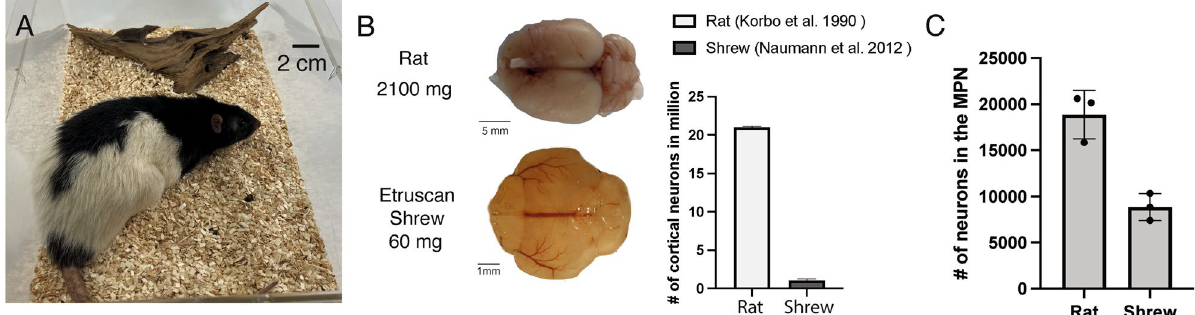
Figure 4. Neocortical and MPN neurons count in rats and Etruscan shrews. ( A ) Comparison of the body size between adult male Etruscan shrew and male rat (6-month-old). ( B ) Left, rat and Etruscan shrew brains. Right, the rat brain contains about 20 × more cortical neurons than that of the shrew. Exact numbers extracted from (Naumann et al. 2012; Korbo et al. 1990) 11,12 and illustrated as a bar graph. ( C ) The rat brain contains only about 2 × more MPN neurons compared to the shrew. Cell counts were performed on three male shrews and three male rats and refer to the sum count of neurons in both